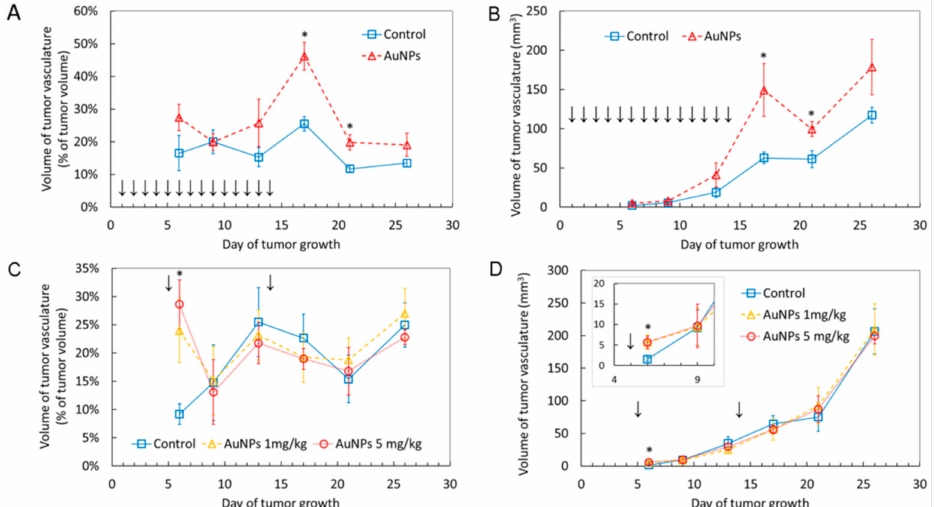
Figure 2. Volume of tumor’s blood vessels shown as an absolute value or as a percent of tumor volume in mice treated with AuNPs intragastrically ( A , B ) and intravenously ( C , D ). Arrows indicate AuNP administration. Data are presented as the mean ± standard error from 6 mice. * p <